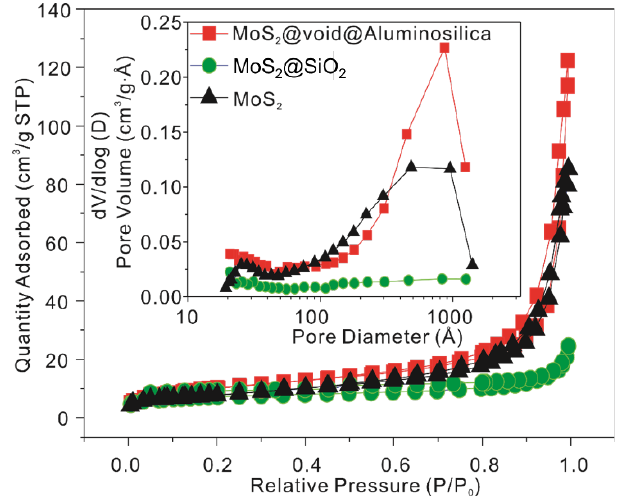
Figure 5. Nitrogen adsorption – desorption isotherms and the corresponding pore-size distribution curves (inset) of the MoS 2 microspheres, the MoS 2 @SiO 2 microspheres, and the MoS 2 @void@Alumi- nosilica microspheres. Table 1. Some physical properties of the three main samples.